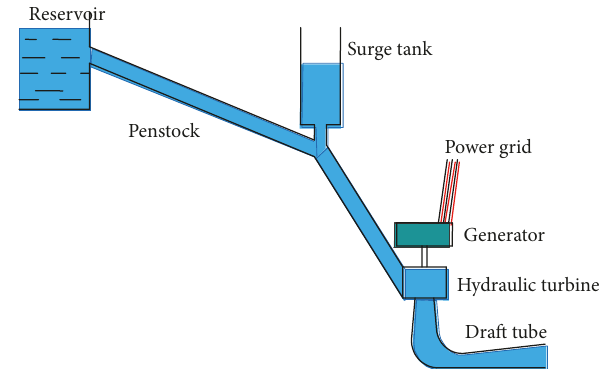
Figure 1: Diagram of an elementary hydropower generation system.